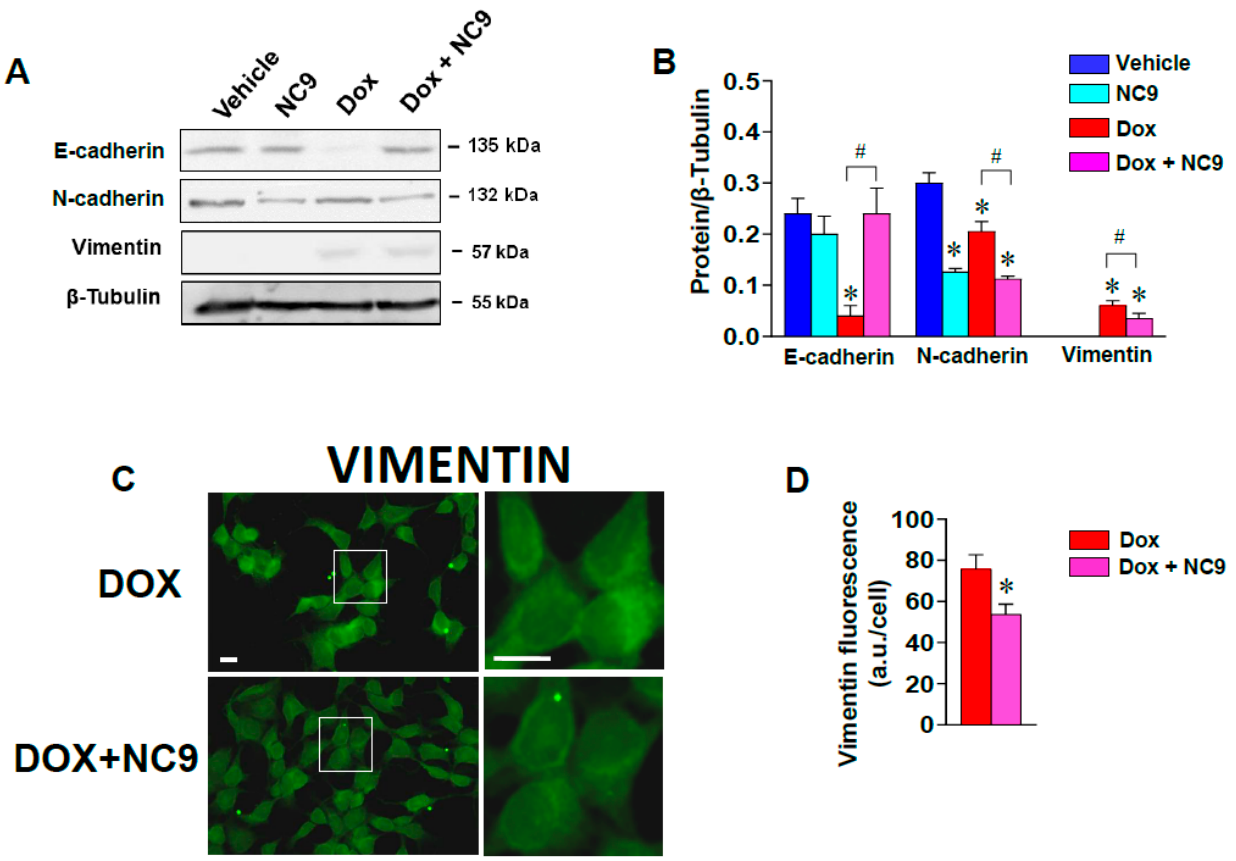
Figure 3. ( A ) Representative immunoblot analysis performed with the indicated antibodies on lysates from MCF-7 cells cultured in the presence of Dox and/or NC9. ( B ) Levels of E-cadherin, N-cadherin, and vimentin as deduced from the analysis of chemiluminescence, normalized with β -Tubulin, which was used as an internal control for the equivalence of the loaded proteins. The data are shown as the mean of three separate experiments performed in triplicate ± SD. * p < 0.05 versus vehicle; # p < 0.05 between bars. ( C ) Representative florescence images of MCF-7 cells grown on glass dishes for 36 h in the presence of Dox ± NC9 and then subjected to immunocytochemical analysis with the anti-vimentin antibody. The regions in the boxes are shown enlarged on the right. Bar: 20 μ m. ( D ) Fluorescence intensity of digitized images calculated by the ImageJ software and reported as arbitrary units for cell (a.u./cell). * p < 0.05 versus Dox.